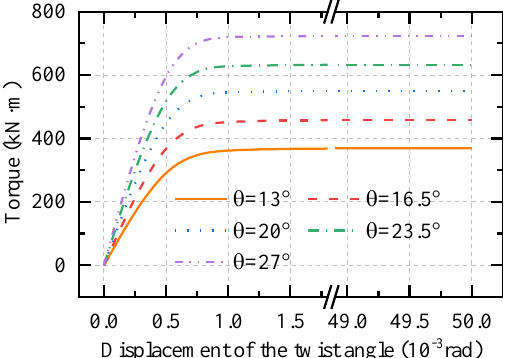
Figure 9. Torque–displacement curves with different central angles. Figure 9. Torque – displacement curves with different central angles. Figure 9. Torque – displacement curves with different central angles.